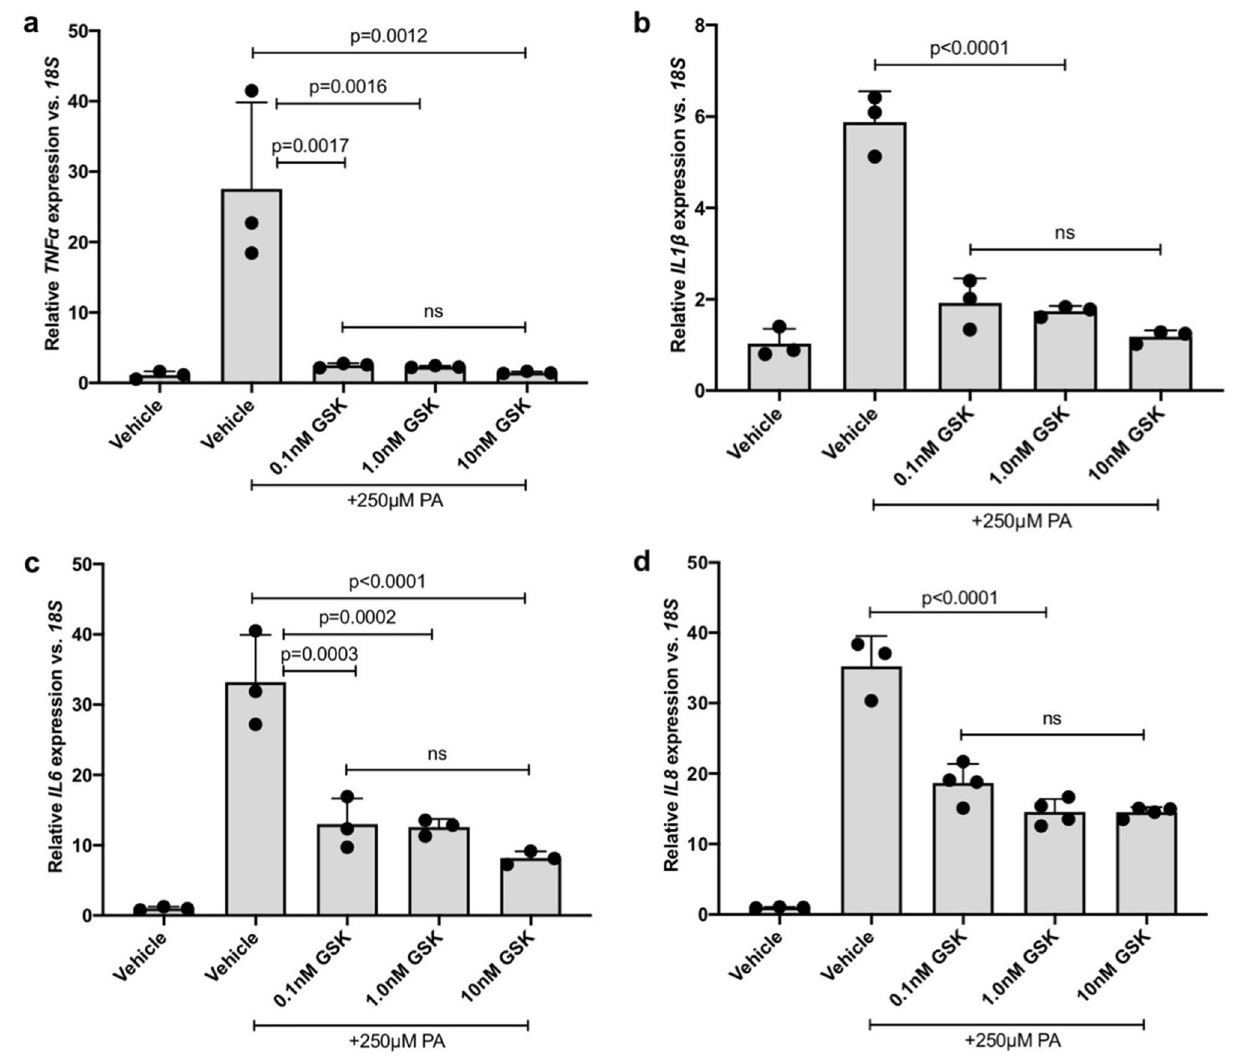
Figure 3. The effect of sEH inhibitor GSK2256294 on PA-induced inflammatory mediator expression by Müller cells. Human Müller cells were treated with PA (250 μM) or PA plus 0.1 nM, 1.0 nM or 10 nM GSK2256294 (sEH inhibitor). After 24 h, total RNA was isolated, and expression was analyzed by qRT-PCR. ( a ) TNFα , ( b ) IL1β , ( c ) IL6 , and ( d ) IL8 expression was significantly decreased by the addition of the sEH inhibitor at each of the concentrations tested. Results depicted are representative of three separate experiments. Data are displayed as mean ± SD (n = 3 or 4 for each